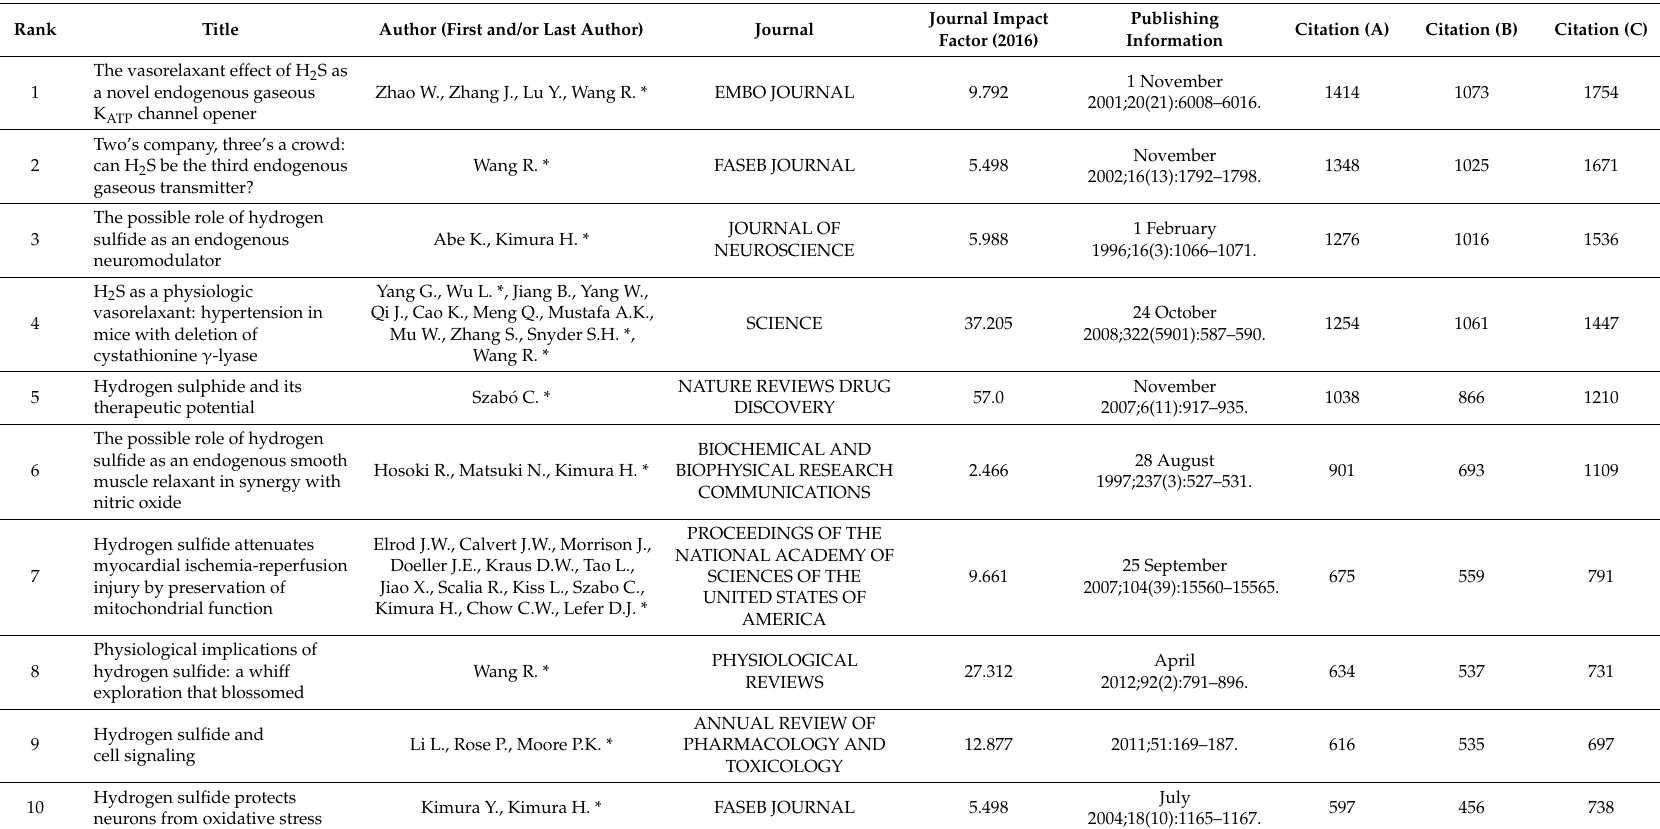
Table 1. Top 10 mostly cited publications in H 2 SBM